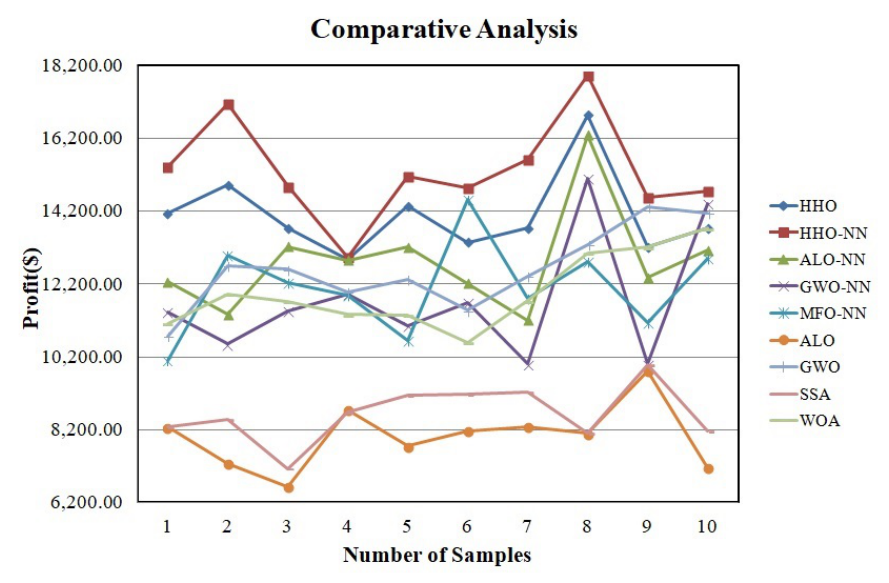
Figure 16. Comparative Analysis Cumulative